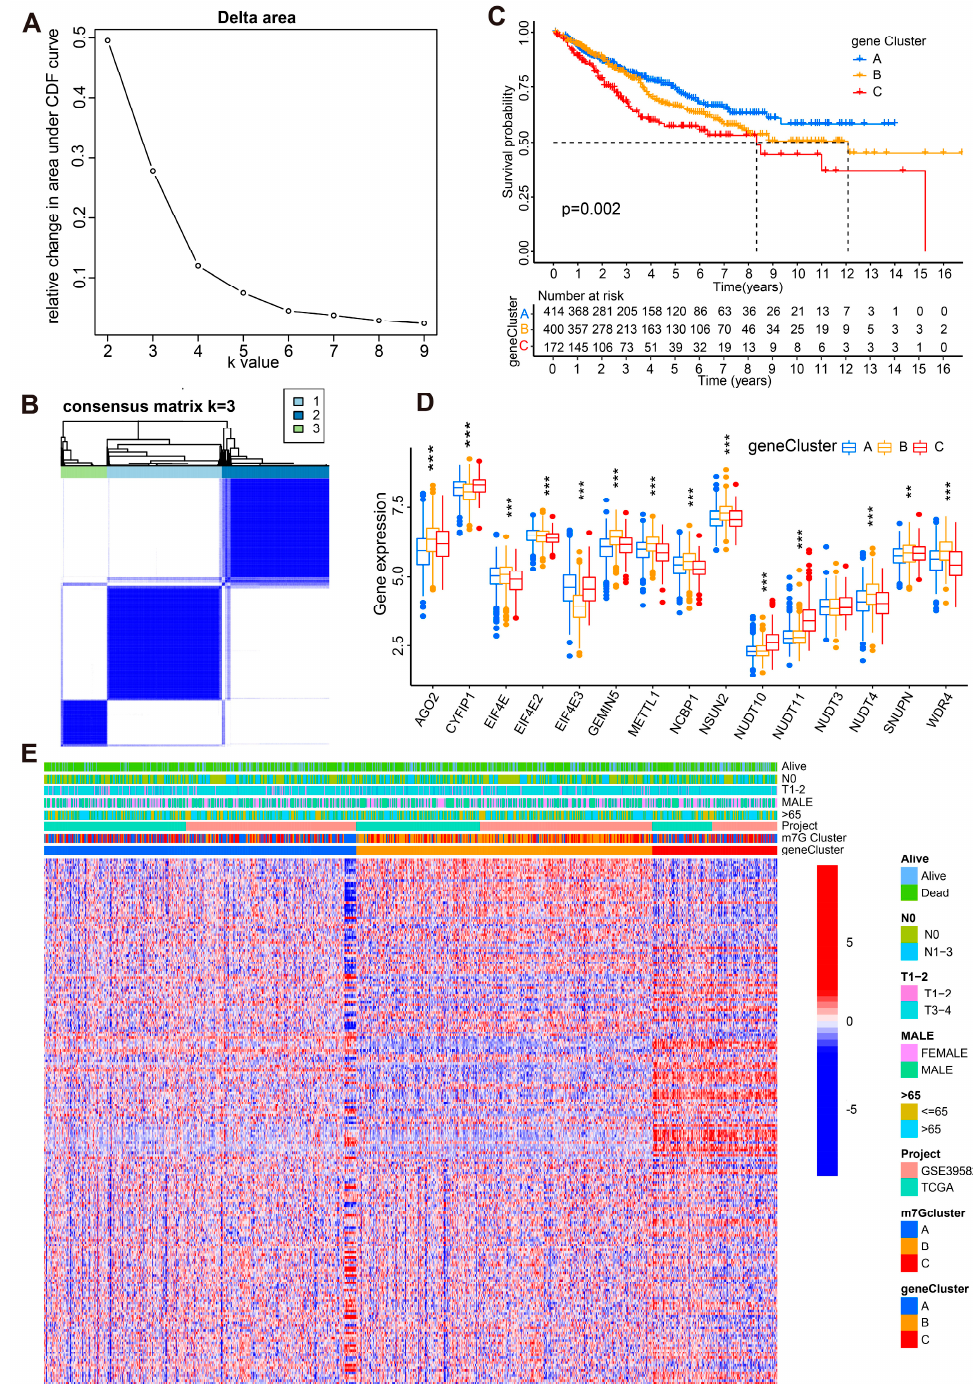
Figure 4. Gene clustering based on prognostic m7G-related DEGs in CC patients. ( A ) Cumulative distribution function curve demonstrates the most effective way of gene clustering. ( B ) The consensus matrix of the clustering analysis based on prognostic m7G-related gene expression profiles via k-means clustering (k = 3). ( C ) KM curves of OS among CC patients from different gene clusters. ( D ) The boxplot for m7G-related genes’ expression levels among CC patients from different gene clusters. ( E ) Heatmap depicting expression levels of prognostic m7G-related genes in CC patients with different clinical characteristics, data sources, m7G clusters, and gene clusters. * p < 0.05, ** p < 0.01, *** p < 0.001.